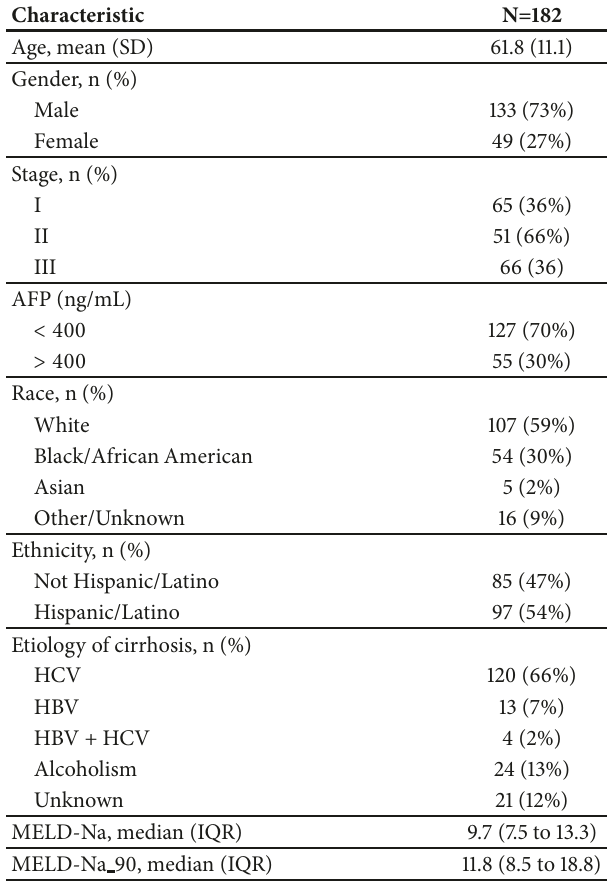
Table 1: Characteristics of the 182 subjects included in this study.